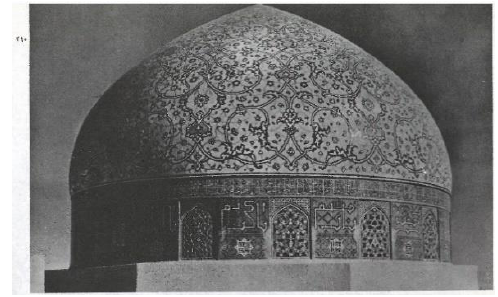
Figure 7. Sheikh Lotfollah Mosque, A. Pope, 1994